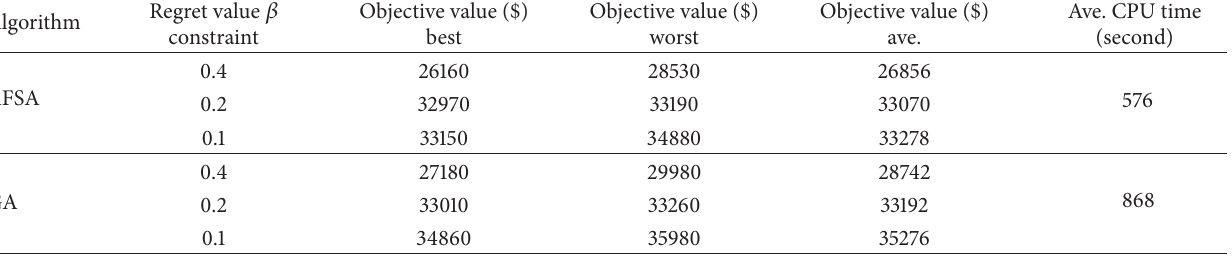
Table 3: Comparison of two algorithms with different regret value 𝛽 constraint.